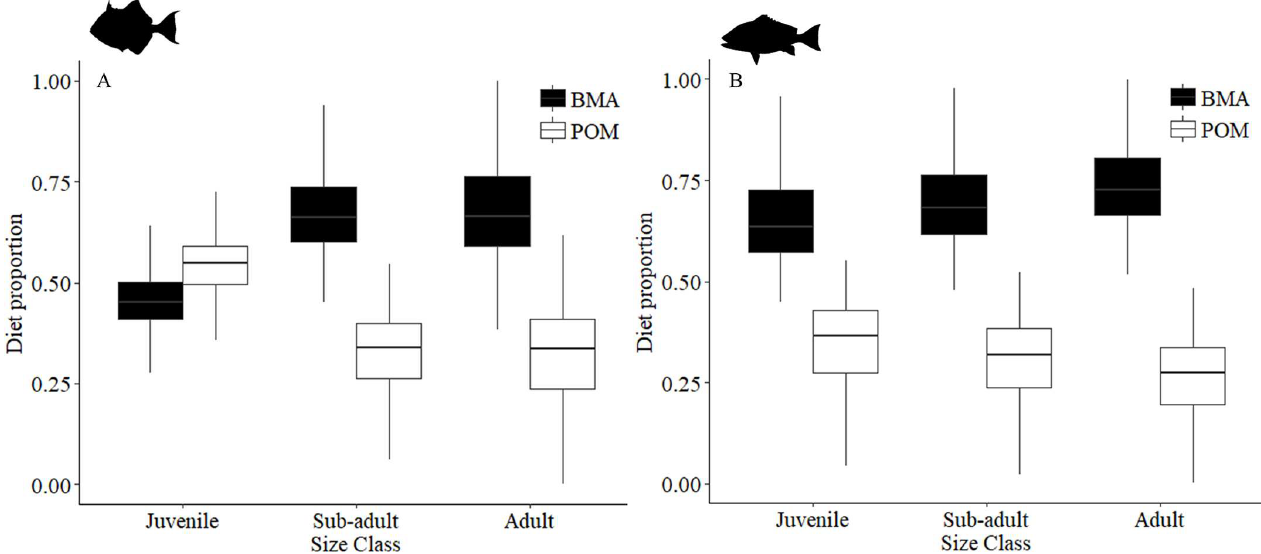
Fig 7. Pelagic (POM) and benthic (BMA) source contribution estimates for gray triggerfish and red snapper. Plots depict contribution estimates for POM and BMA to juvenile, sub-adult and adult size classes. (A) Depicts source contribution estimates for gray triggerfish, and (B) depicts source contribution estimates for red